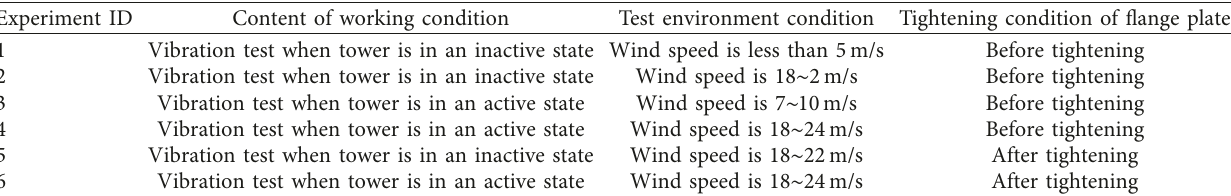
Table 3: Vibration test conditions of the wind turbine towers.